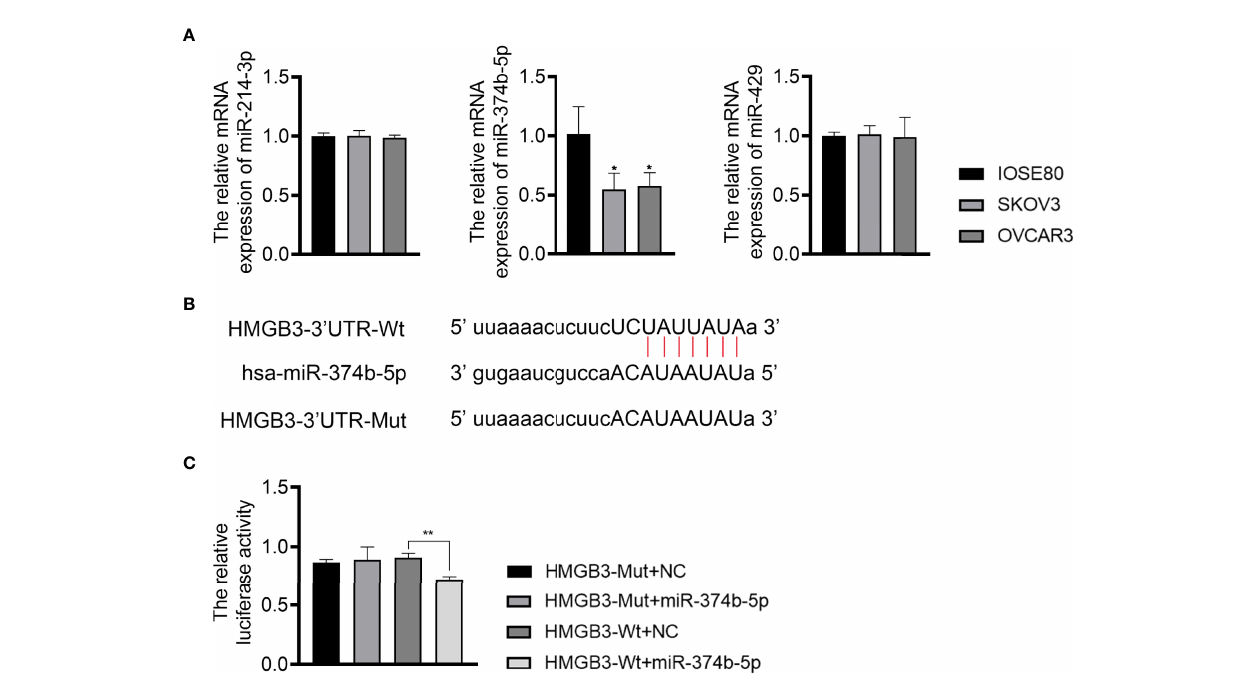
FIGURE 5 | MiR-374b-5p was predicted to directly target HMGB3. (A) The relative expression of miR-374b-5p, miR-429, and miR-214-3p in EOC cell lines (SKOV3 and OVCAR3) and those of normal IOSE80 cells was detected by qPCR. * P < 0.05 vs. IOSE80. (B) The binding site of has-miR-374b-5p and HMGB3. (C) The interaction between miR-374b-5p and HMGB3 was validated through dual-luciferase reporter assay. ** P <